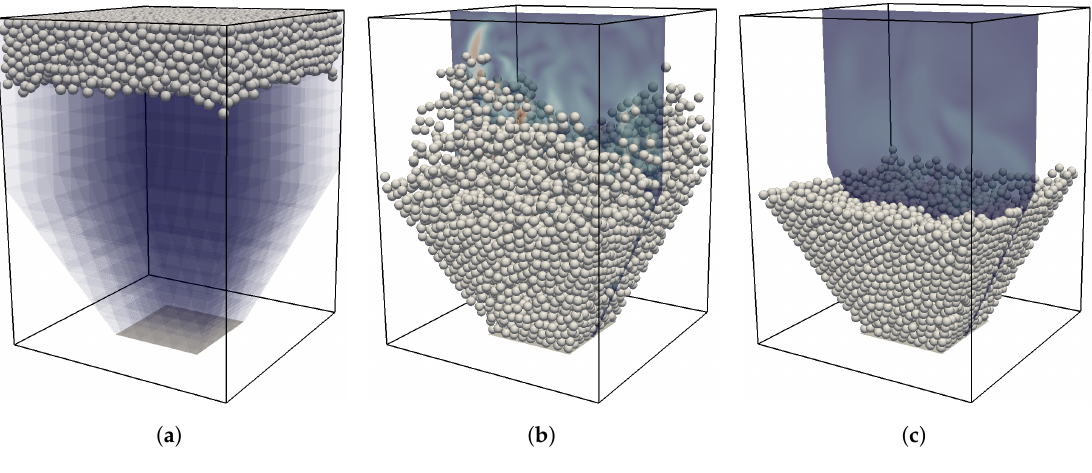
Figure 9. Visualization of the temporal evolution of the particles and the fluid velocity in the hopper clogging simulation. ( a ) Initial state with block structure. ( b ) Active settling phase. ( c ) Final, completely settled